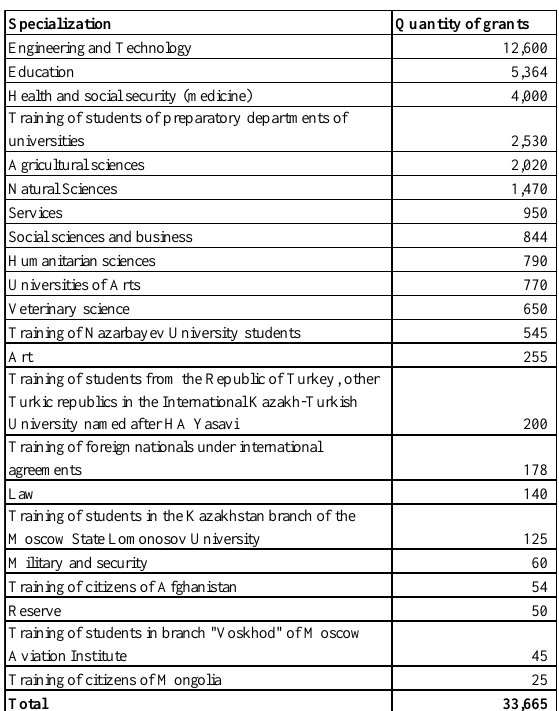
Table 2: State educational order for training